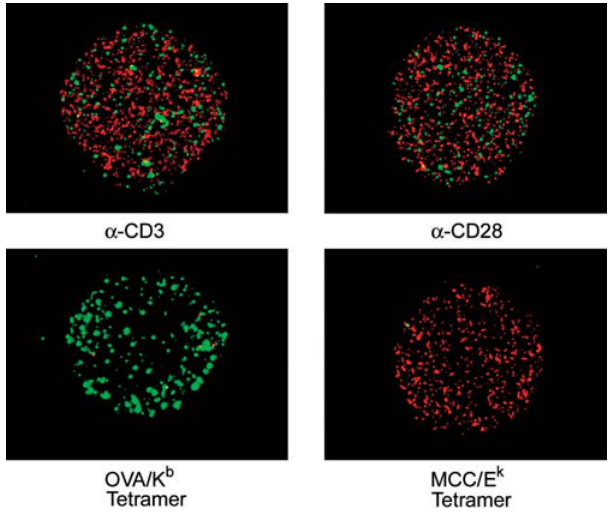
Figure 2. Specificity of Lymphocyte Immobilization by Peptide–MHC Arrays Prelabeled, OVA-specific OT-1 (green) and MCC-specific 5c.c7 (red) lymphocytes (6 3 10 5 ) were mixed at a 1:1 ratio and added to the preprinted peptide–MHC array. While anti-CD3 and anti-CD28 mAb spots (left and right top panels) immobilize both lymphocyte populations, the OVA and MCC tetramers (left and right bottom panels) capture only the OVA-specific and MCC-specific cells, respectively. Cells were labeled with DiO and DiD lipophilic tracers that incorporate into the cell membrane and do not affect the specificity of cell capture. The printed peptide–MHC tetramer spots contain the fluorescent dye, which allows visualization of peptide– MHC spot borders (data not shown). DOI: